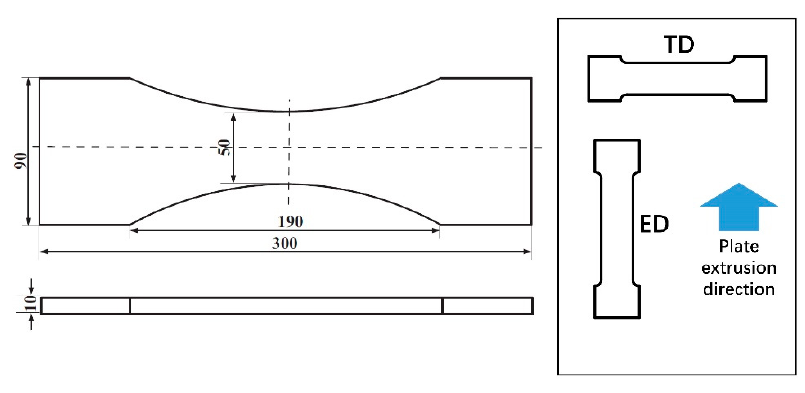
Figure 1. Specimen geometry (mm) and sampling direction.